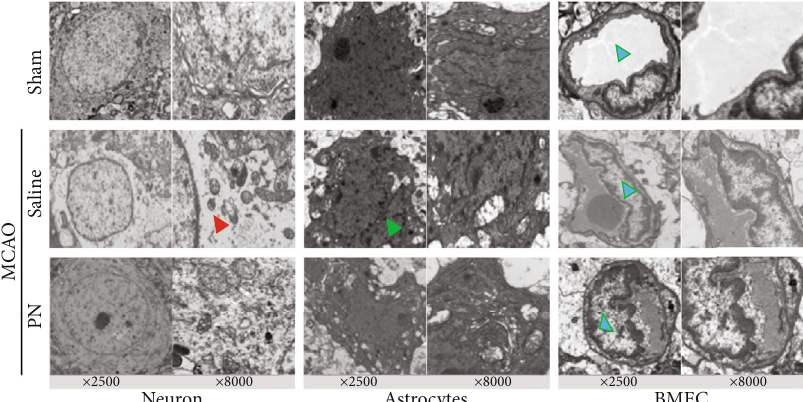
Figure 3: The e ff ect of PN on ultrastructural changes of NVU. Similar experiments were performed at least 4 times. BMEC represents brain microvascular endothelial cell. The red triangle indicates a severe swollen/in fl ammation around neuron, the green triangle indicates an irregular nucleus. The blue triangle indicates the lumen side of brain TC ACAATA-3 ′ (reversed); primers used for Bcl2 ampli fi ca-